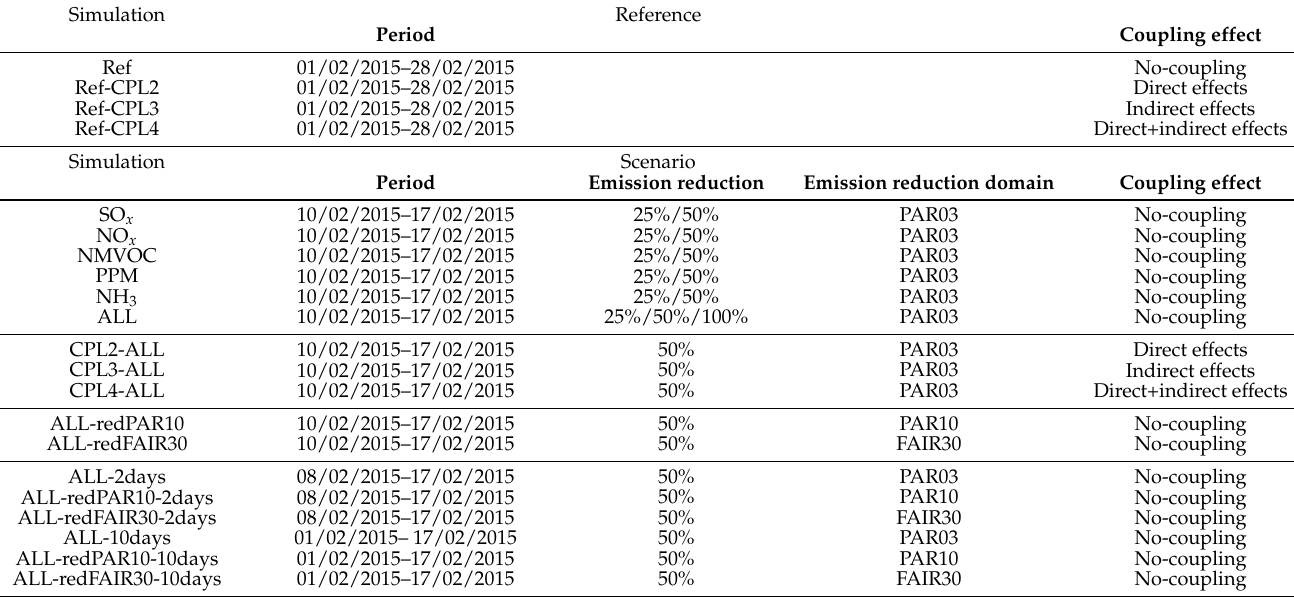
been performed for all three domains, the ”emission reduction domain” for the scenario part of the table regards to the domain from which the emission reductions have